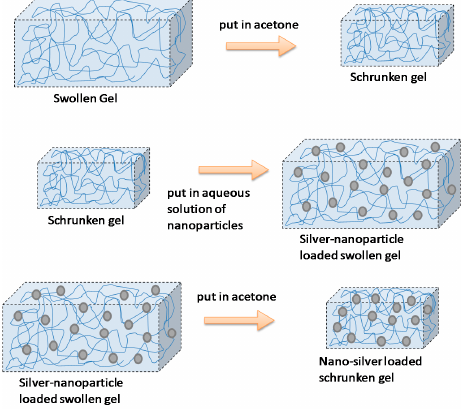
Figure 6. Encapsulation of silver nanoparticles within a hydrogel following the breathing-in/breathing-out (BI-BO) methodology. Reproduced with permission from [51].